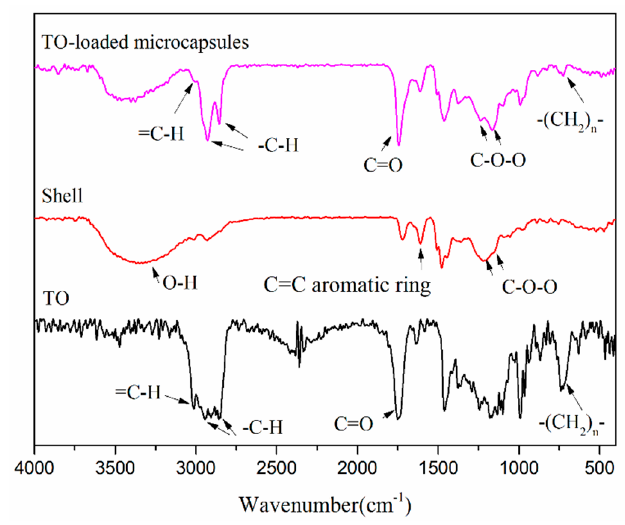
Figure 4. FTIR spectra of shell, TO-loaded microcapsules (core/shell ratio of 3:1) and TO core.